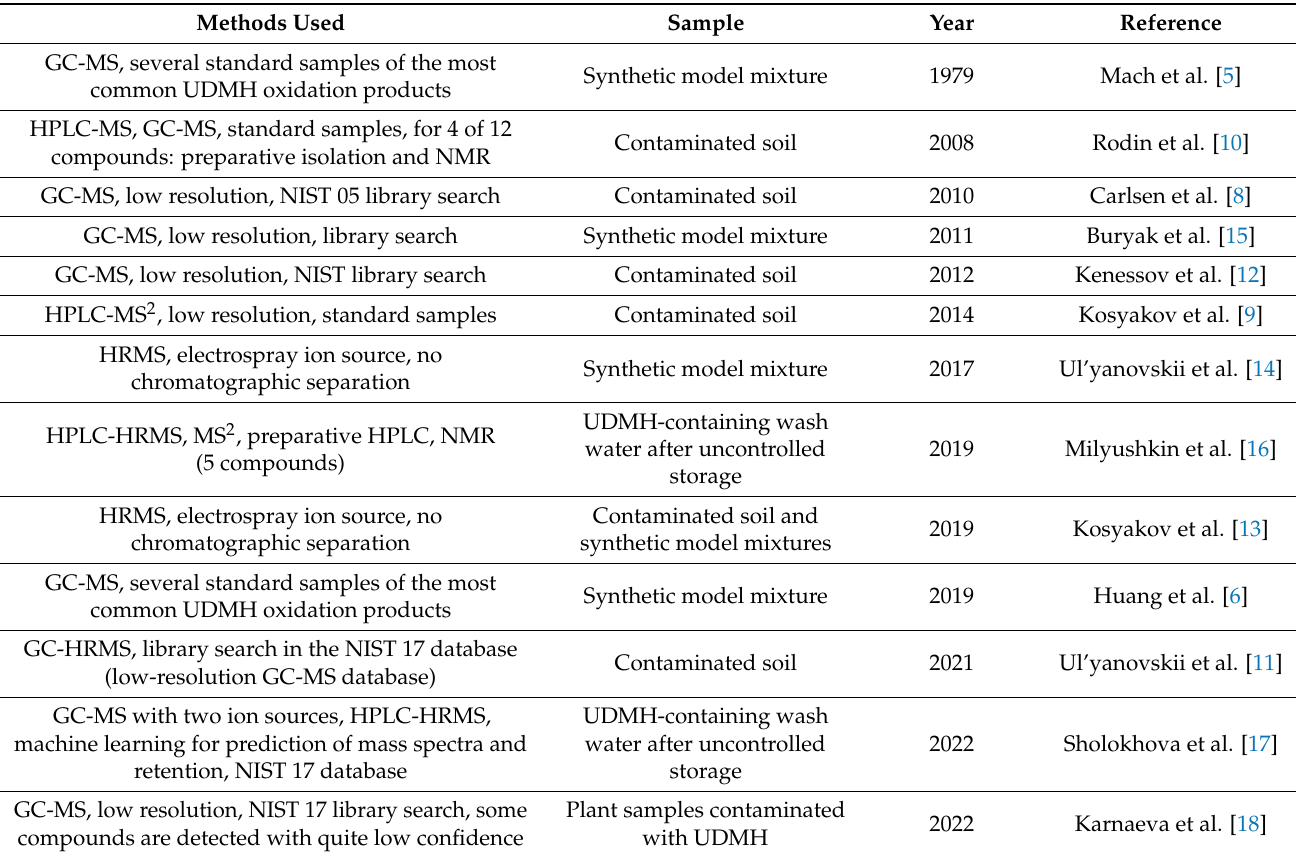
Table 1. Previous works devoted to determination of structures of new, unknown UDMH transfor- mation